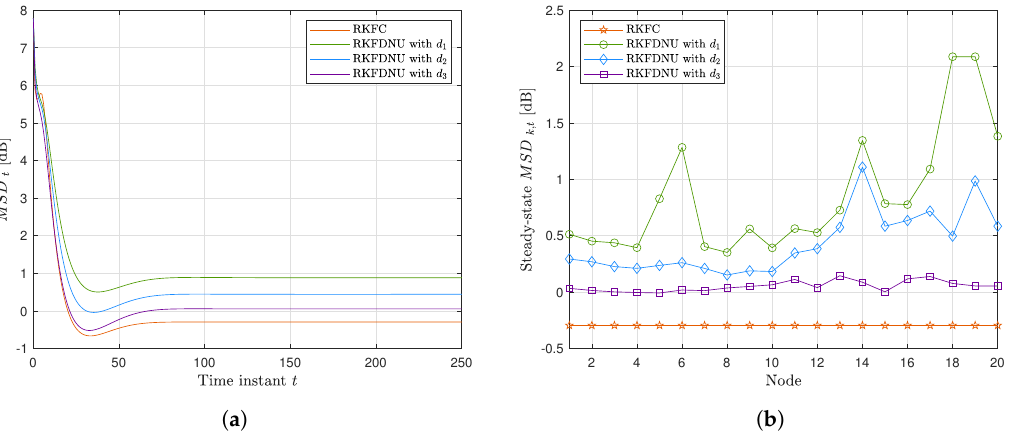
Figure 8. Performance of RKFDNU across the three networks compared with RKFC. ( a ) Least favorable mean square deviation with tolerance c = 0.06. ( b ) Least favorable mean square deviation for each node in the steady-state with tolerance c = 0.06.